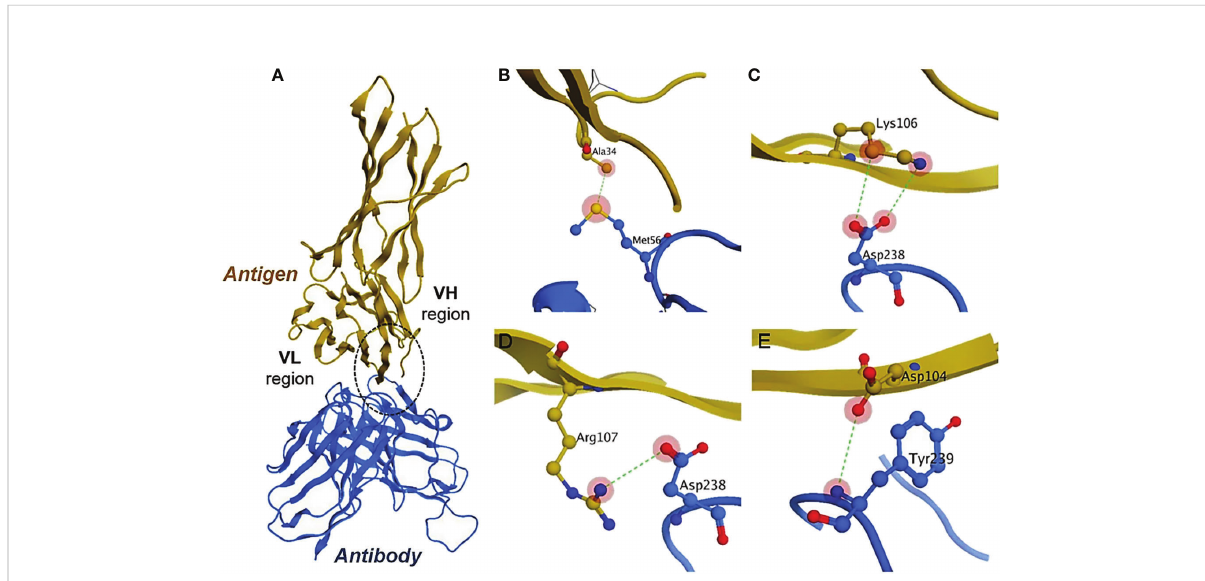
FIGURE 9 Antigen-antibody interaction analysis. (A) show the binding interactions of PD-L1 and scFv molecule. The highlighted encircle shows the CDRs interactions with antigen sites. (B – E) models indicate the site-speci fi c hydrogen interactions between amino acid